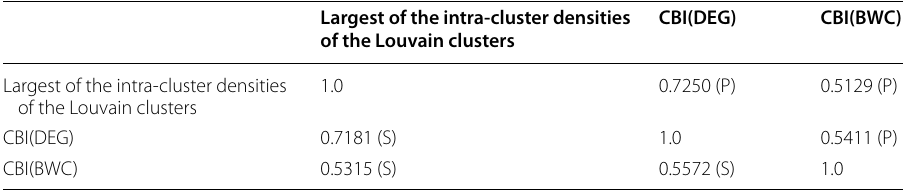
Table 4 Pearson’s (P) and Spearman’s (S) correlation coefficient values Largest of the intra‑cluster densities of the Louvain clusters Largest of the intra-cluster densities of the Louvain